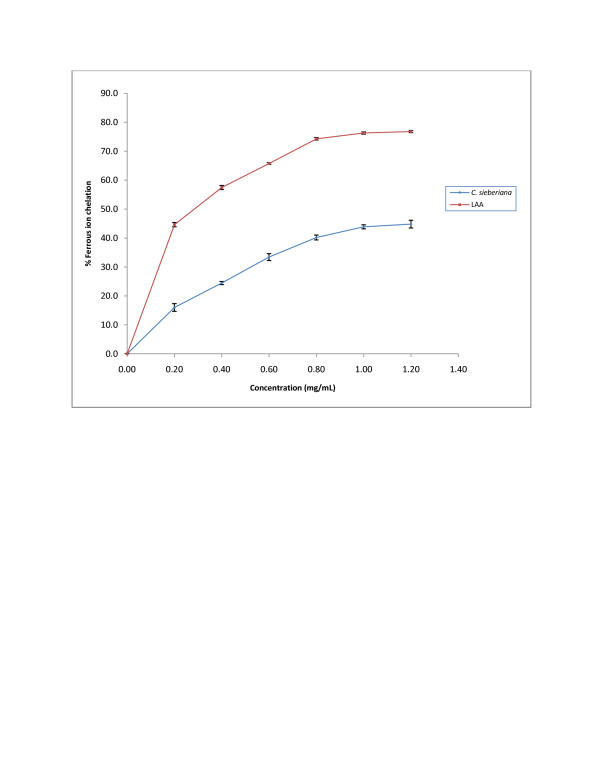
Ferrous ion chelating effect ofC. sieberianaroots bark extract. L-ascorbic acid (LAA) was used as a reference compound. Results are means ± SEM of n = 3.